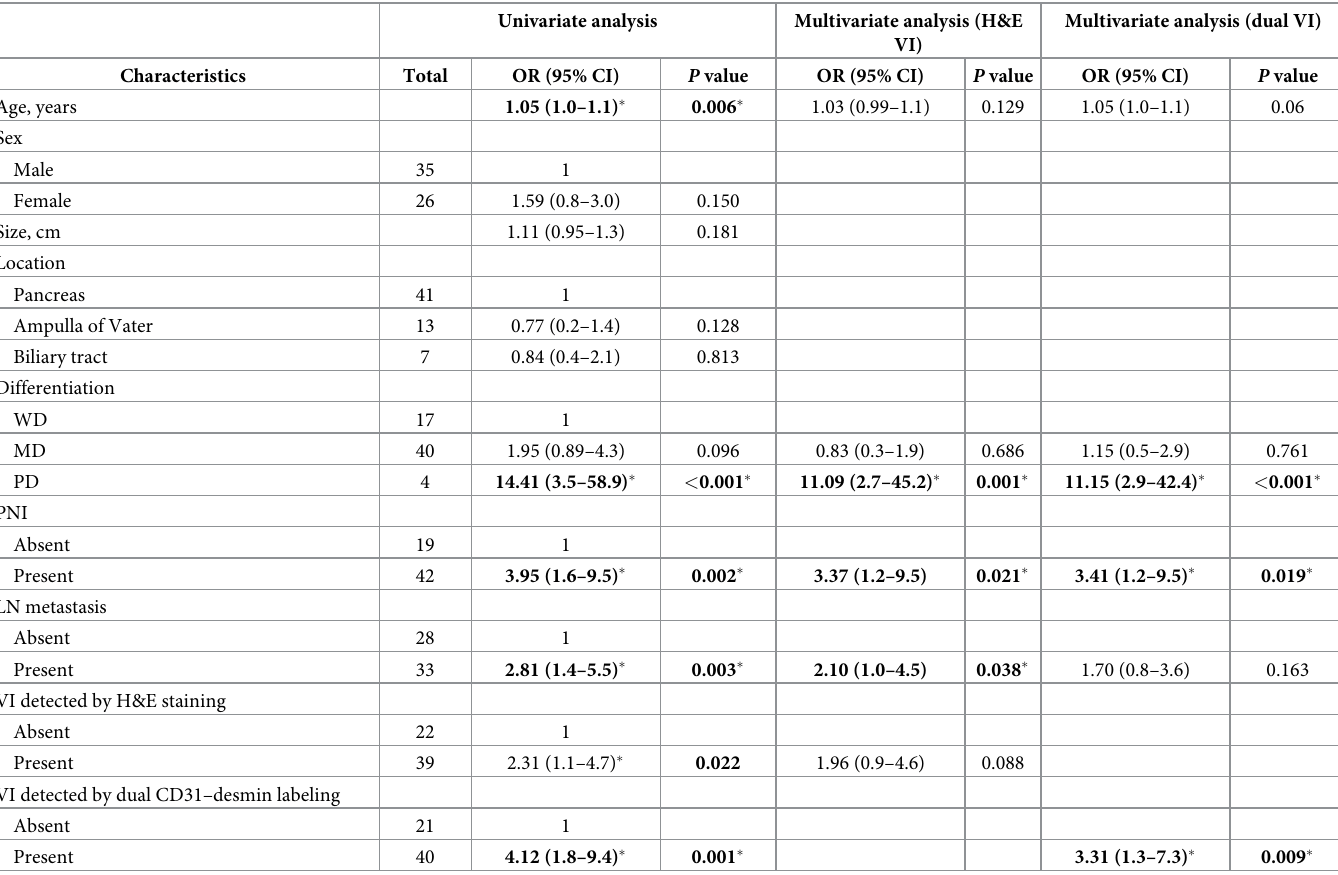
Table 6. Univariate and multivariate analyses of pancreatobiliary tract cancer in the validation